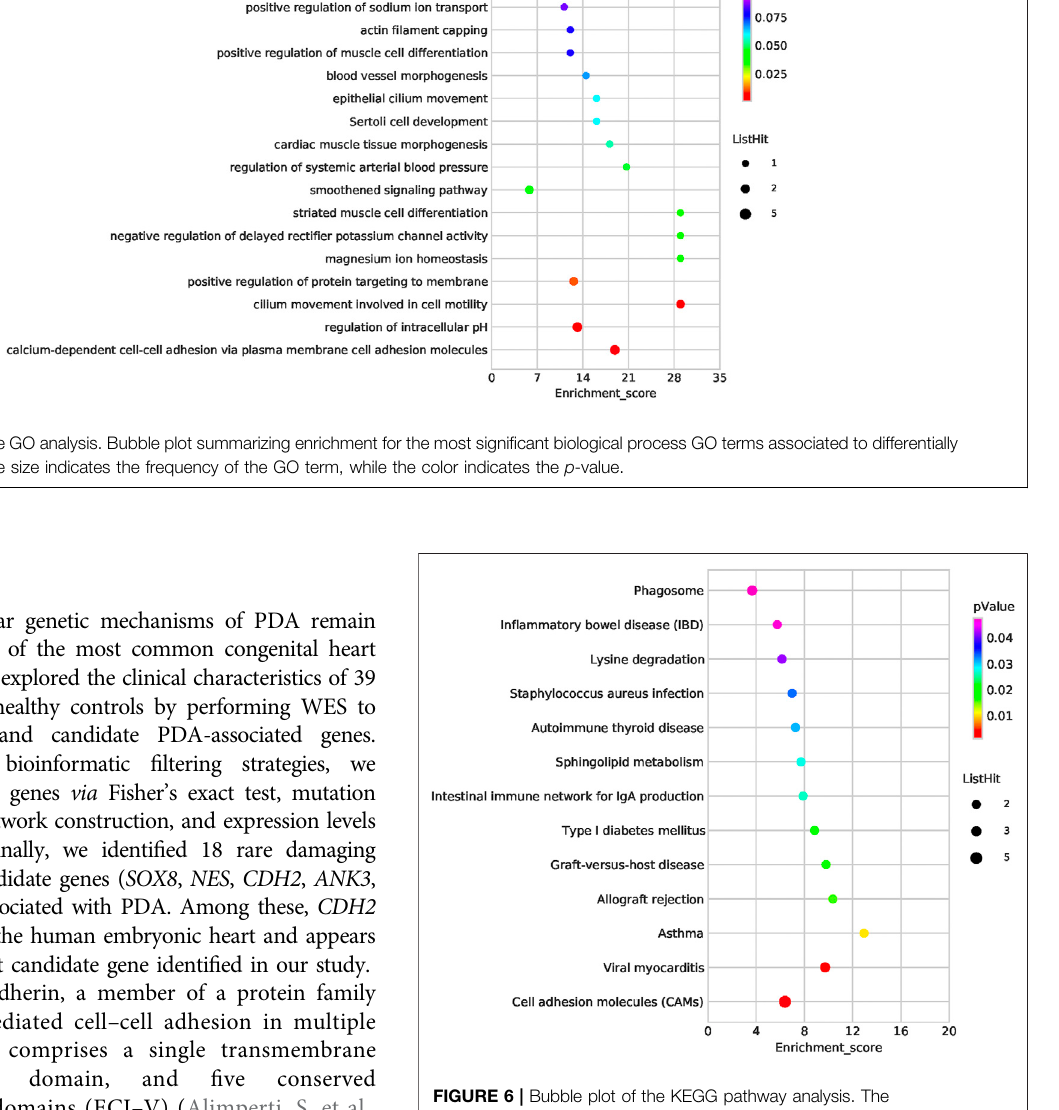
FIGURE 6 | Bubble plot of the KEGG pathway analysis. The representative enriched pathways shown by KEGG analysis. The bubble size indicates the frequency of the KEGG term, while the color indicates the p